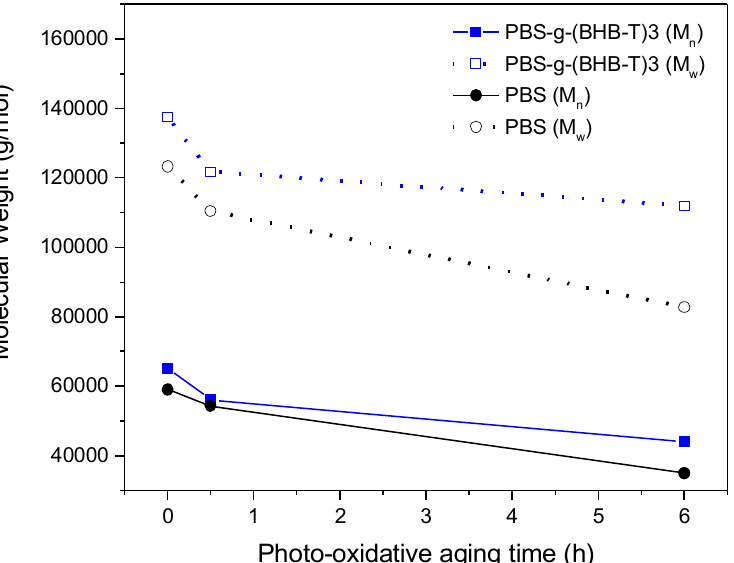
Figure 4. Number- and weight-average molecular weight of PBS and PBS-g-(BHB-T)3 as a function of photo-oxidation aging time.